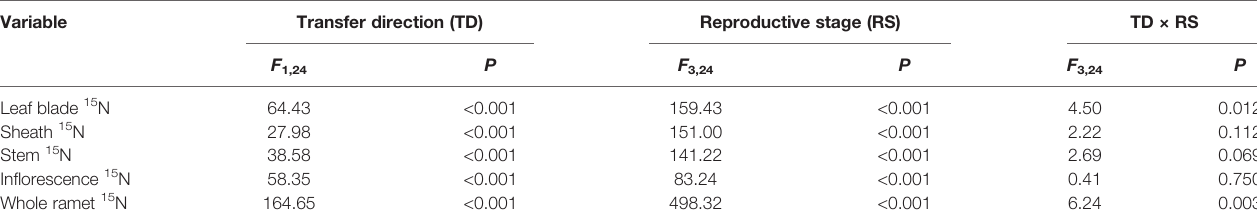
TABLE 3 | Two-way ANOVA for the effects of transfer direction, reproductive stage, and their interaction on amounts of 15 N (log-transformed) translocated from labeled vegetative ramets toward the leaf blade, sheath, stem, in fl orescence, and whole ramet of reproductive ramets. Variable Transfer direction (TD)